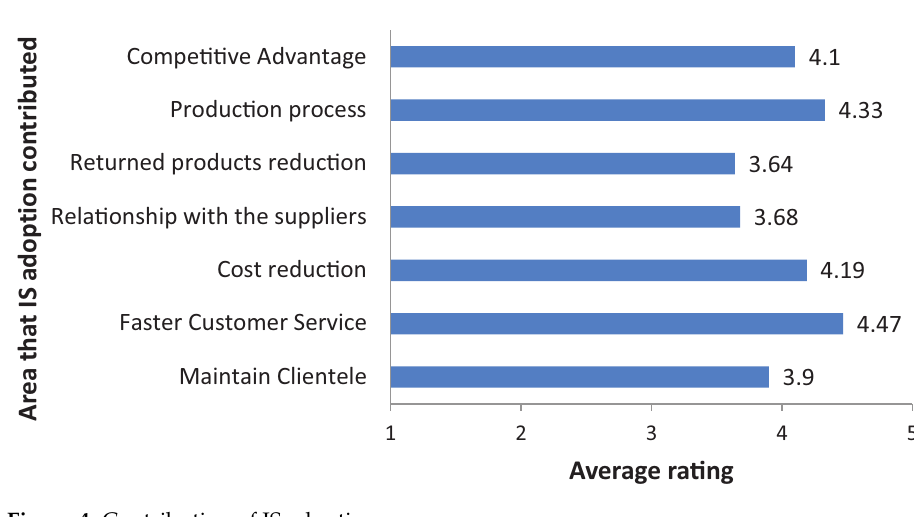
Figure 4. Contribution of IS